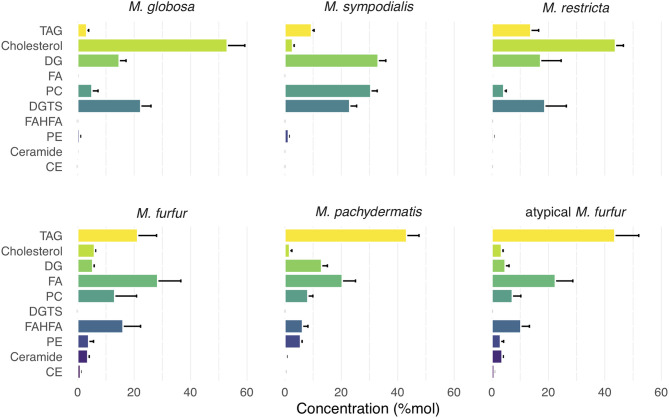
Relative concentration of major lipid classes in five species of Malassezia and a putative M. furfur (atypical M. furfur) strain. Lipid classes are organized top-down according to the average concentration throughout all species. Species are organized from left to right according to the decreasing concentration of triacylglycerols (TAG) lipids. Each lipid class is expressed in %mol by their relative molar contribution to total lipids. Cholesterol should be read as: cholesterol and closely related sterols that could currently not be resolved by the technique used. Bars and lines denote mean and standard deviation (SD), respectively. TAG, triglycerides; DG, diglycerides; FA, fatty acids; PC, phosphatidylcholine; DGTS, diacylgyceryltrimethylhomoserine; FAHFA, fatty acids hydroxyl fatty acids; PE, phosphatidylethanolamine; CE, cholesteryl ester.